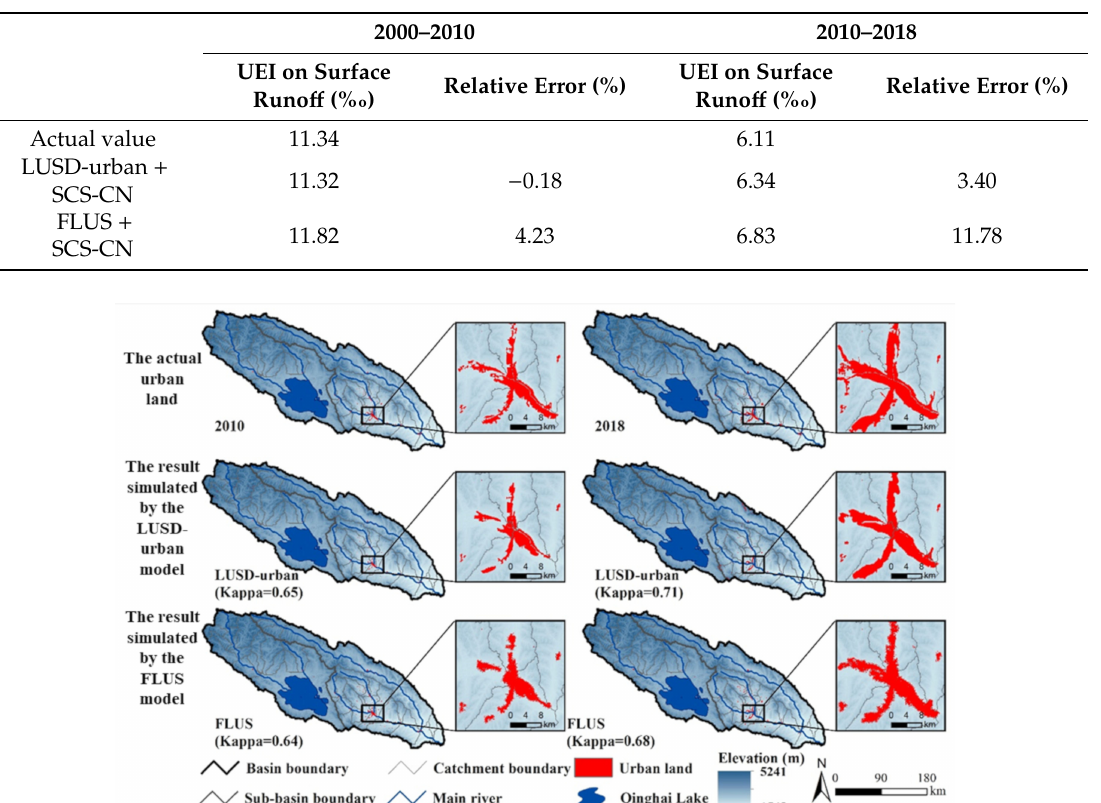
Table 8. The comparison between the LUSD-urban and future land use simulation (FLUS) models.